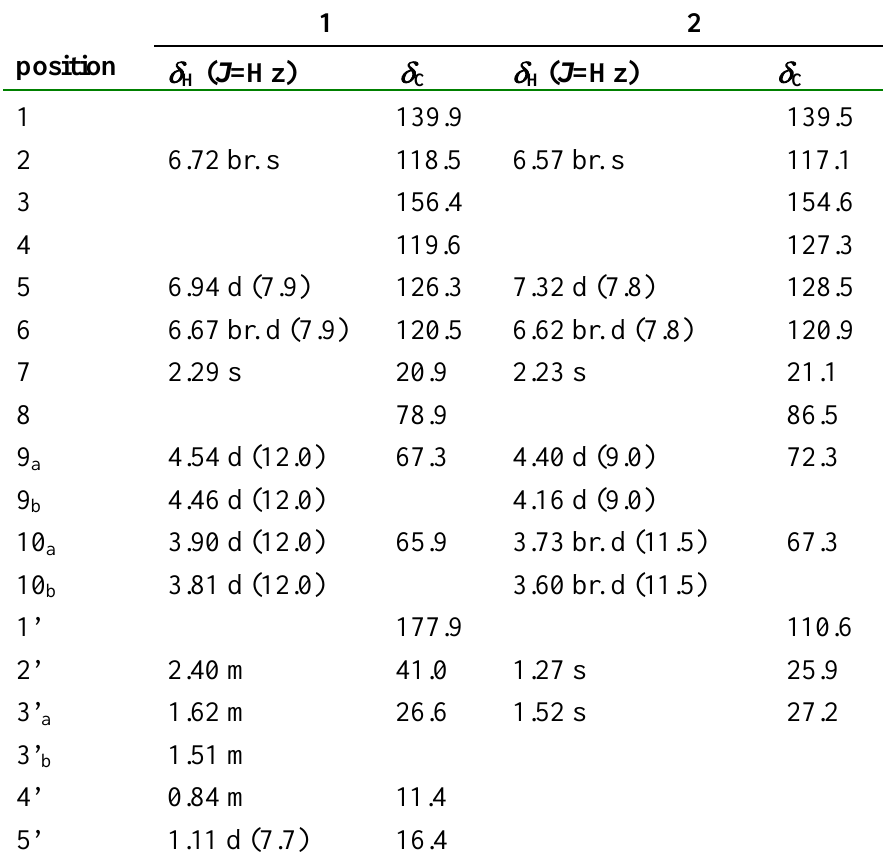
Table 1. 1 H- and 13 C-NMR spectra data for compounds 1 and 2 a .